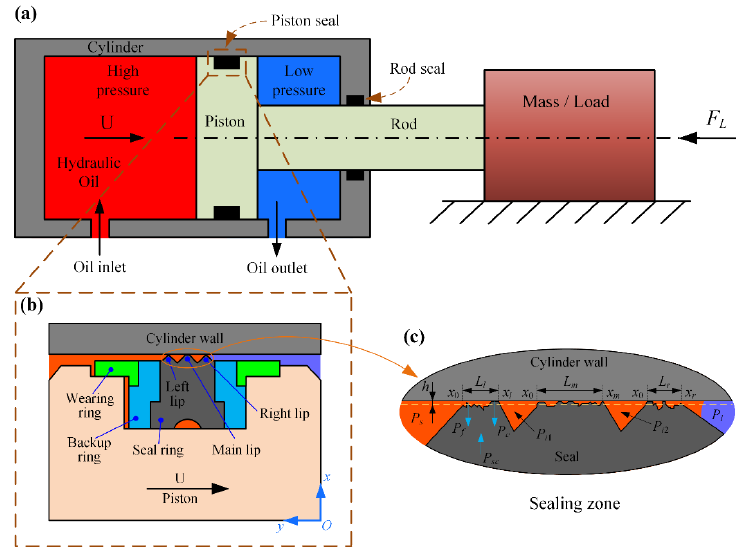
Figure 1. Working schematic of the DAS combined seal: ( a ) Working condition of hydraulic cylin- der; ( b ) DAS combined seal structural composition; ( c ) details information of the sealing zone.